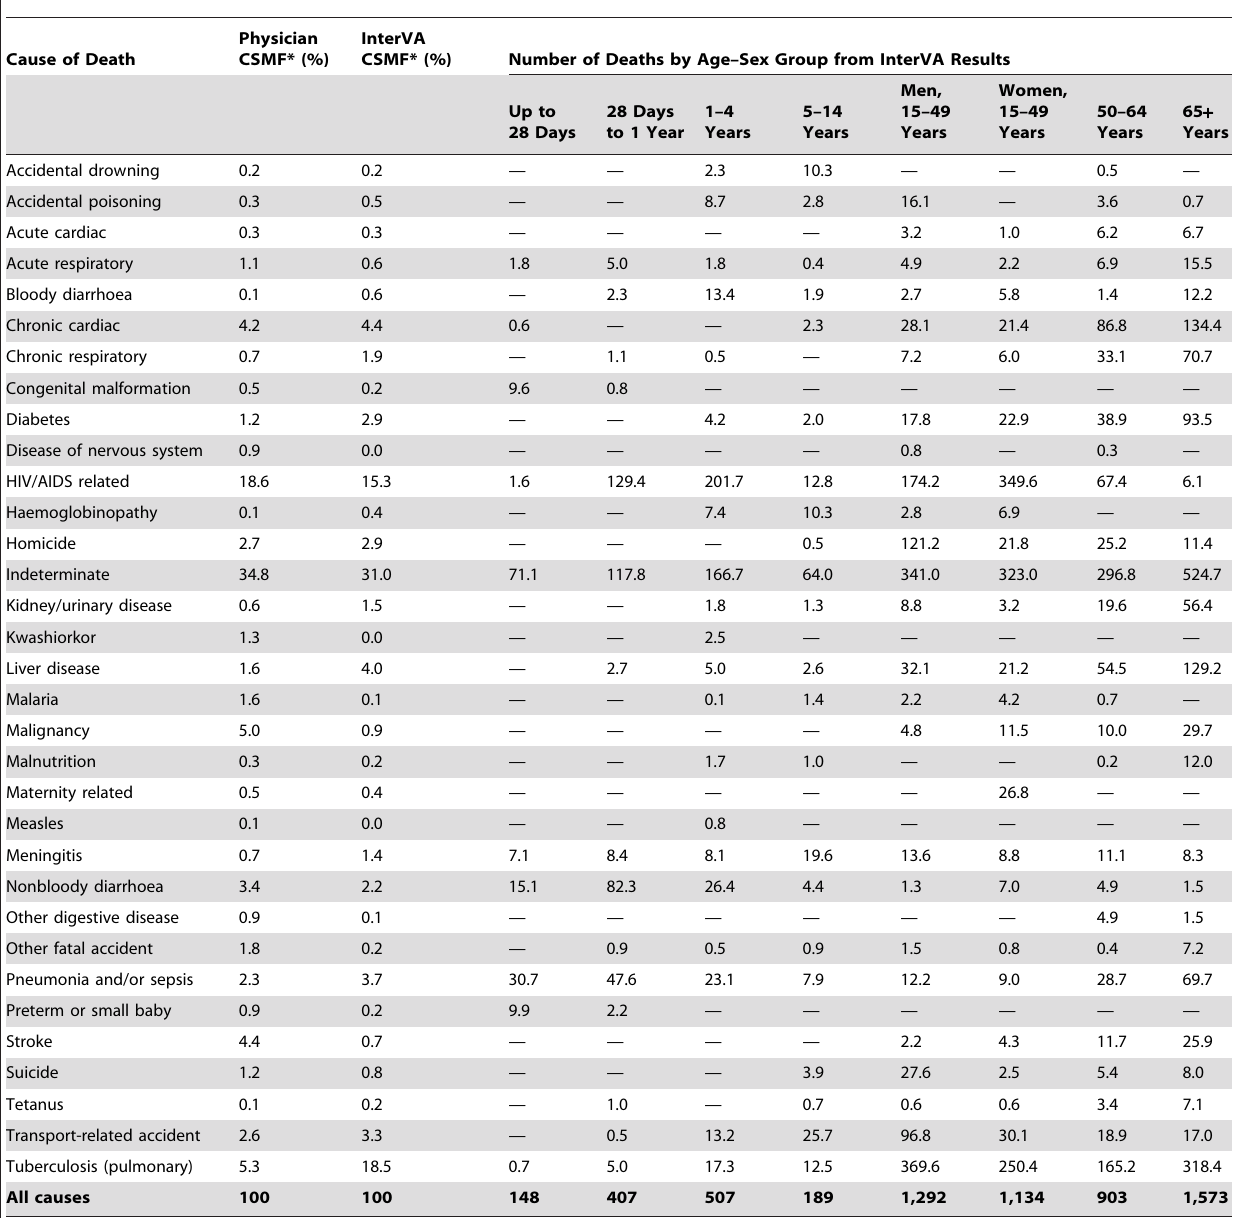
Cause-specific mortality fractions from physician coding of the same dataset are shown for comparison in the second column. *Cause specific mortality fraction, across all